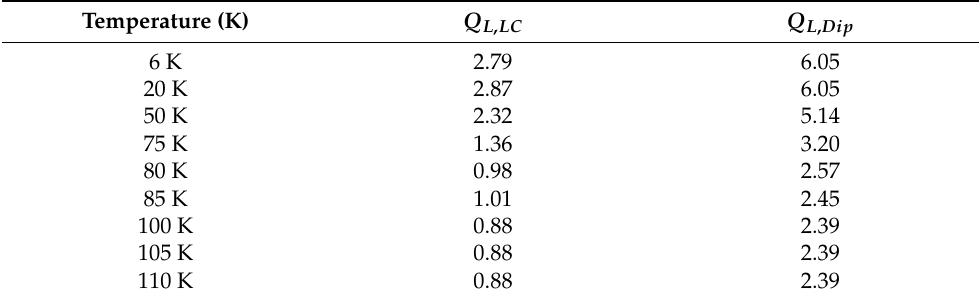
Table A1. Loaded quality factors associated with both LC and dipolar resonances for direct device at different